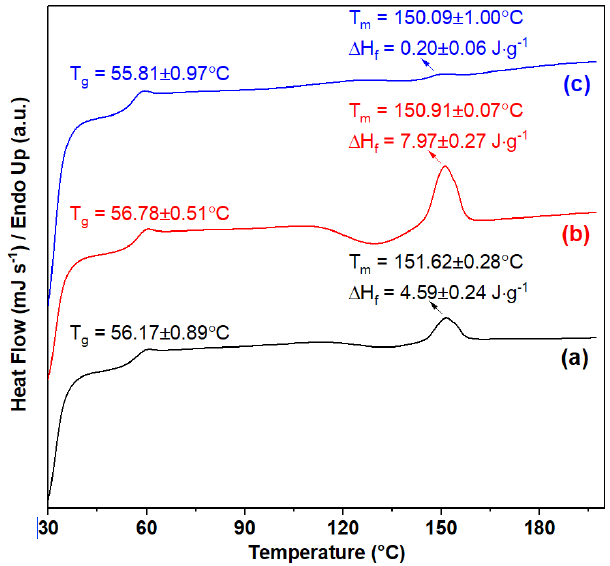
Figure 2. Thermograms of ( a ) virgin TPS, ( b ) TPS/CaCl 2 10 wt% and ( c ) TPS/CaCl 2 20 wt% composite films. T g is the glass transition temperature, T m is the melting temperature and ∆ H f is the fusion enthalpy change obtained from the peak area in the second heating scan of DSC curves. Average and mean values are referent to analysis in triplicates.